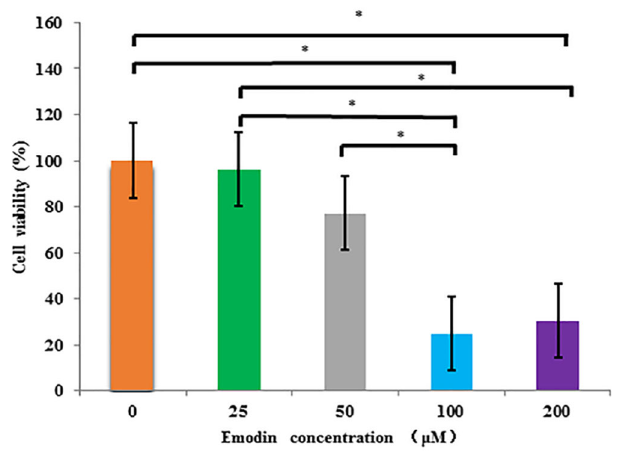
Figure 4. The viability of HepG2 cells exposed to Emodin at different concentrations (0–200 µ M) in microfluidic culture by CCK8 kit ( n = 3). * multiple comparisons, p < 0.05.